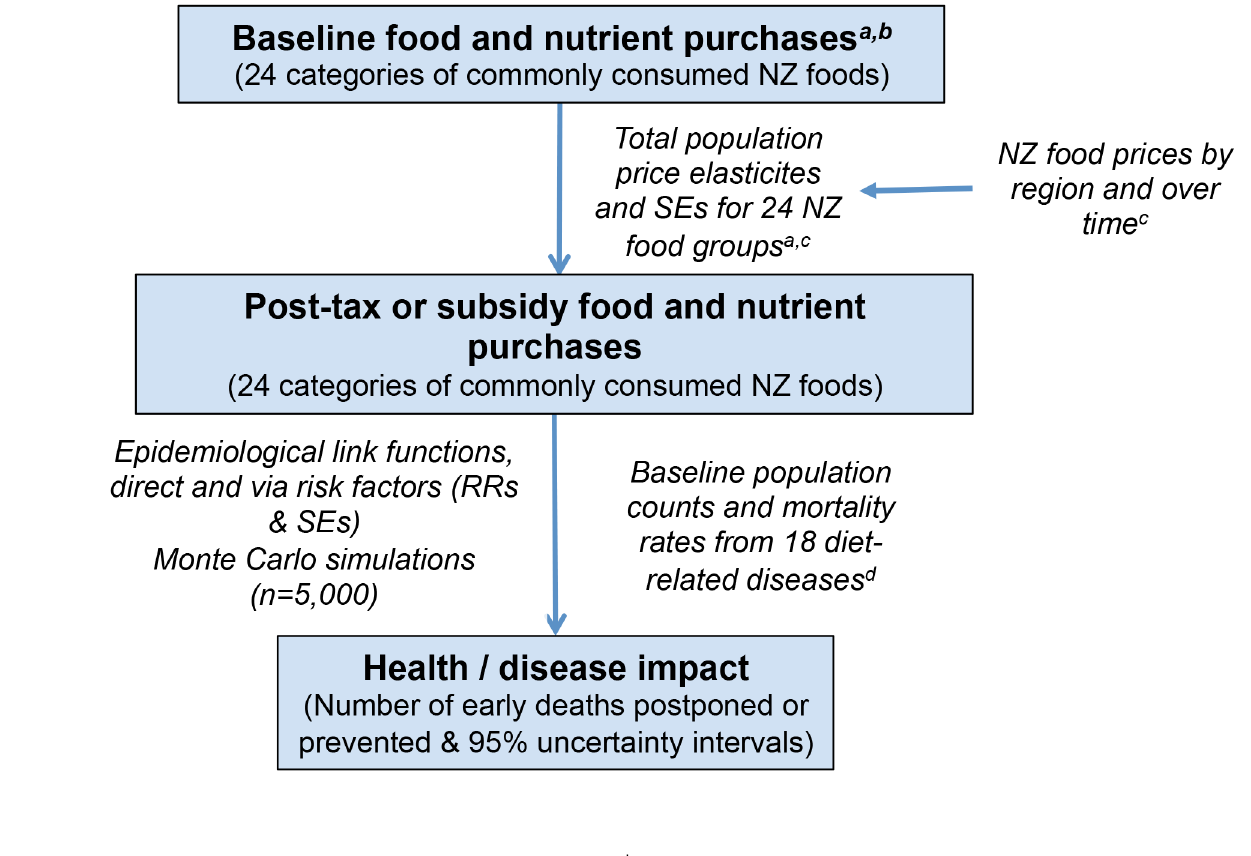
Fig 1. Data sources used as inputs to